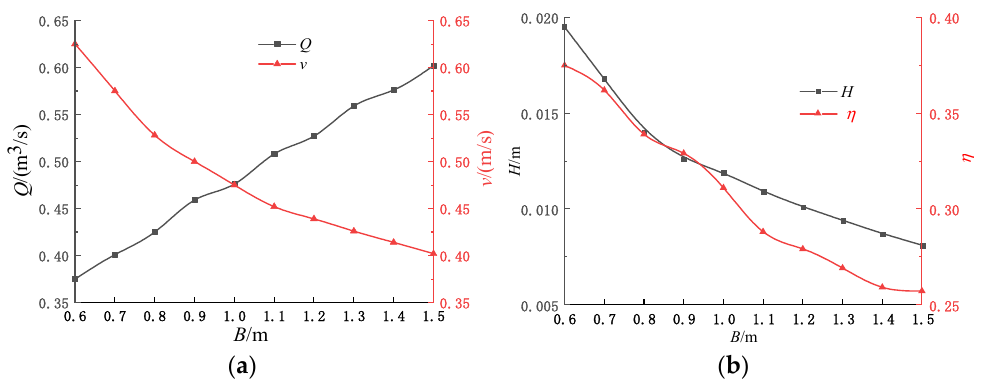
Figure 9. Comparison of hydrodynamic performance of different passage widths: ( a ) Width-flow and velocity curve comparison; ( b ) Width-head and efficiency curve comparison.